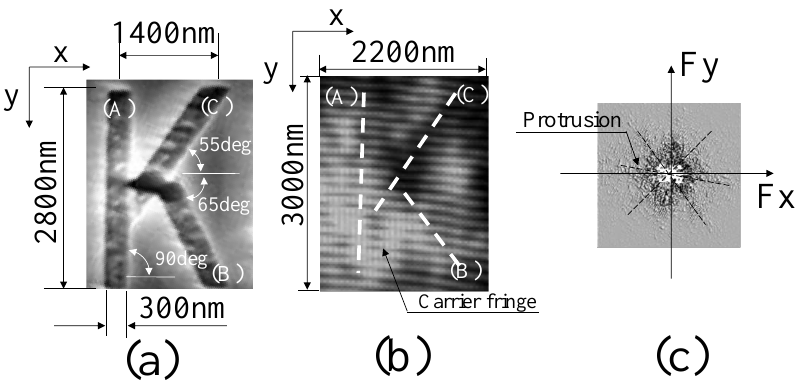
Figure 9. Two-dimensional analysis using alphabet character “K”. ( a ) SEM image of alphabet character “K”; ( b ) Speckle pattern of measured object; ( c ) Speckle pattern in frequency domain.